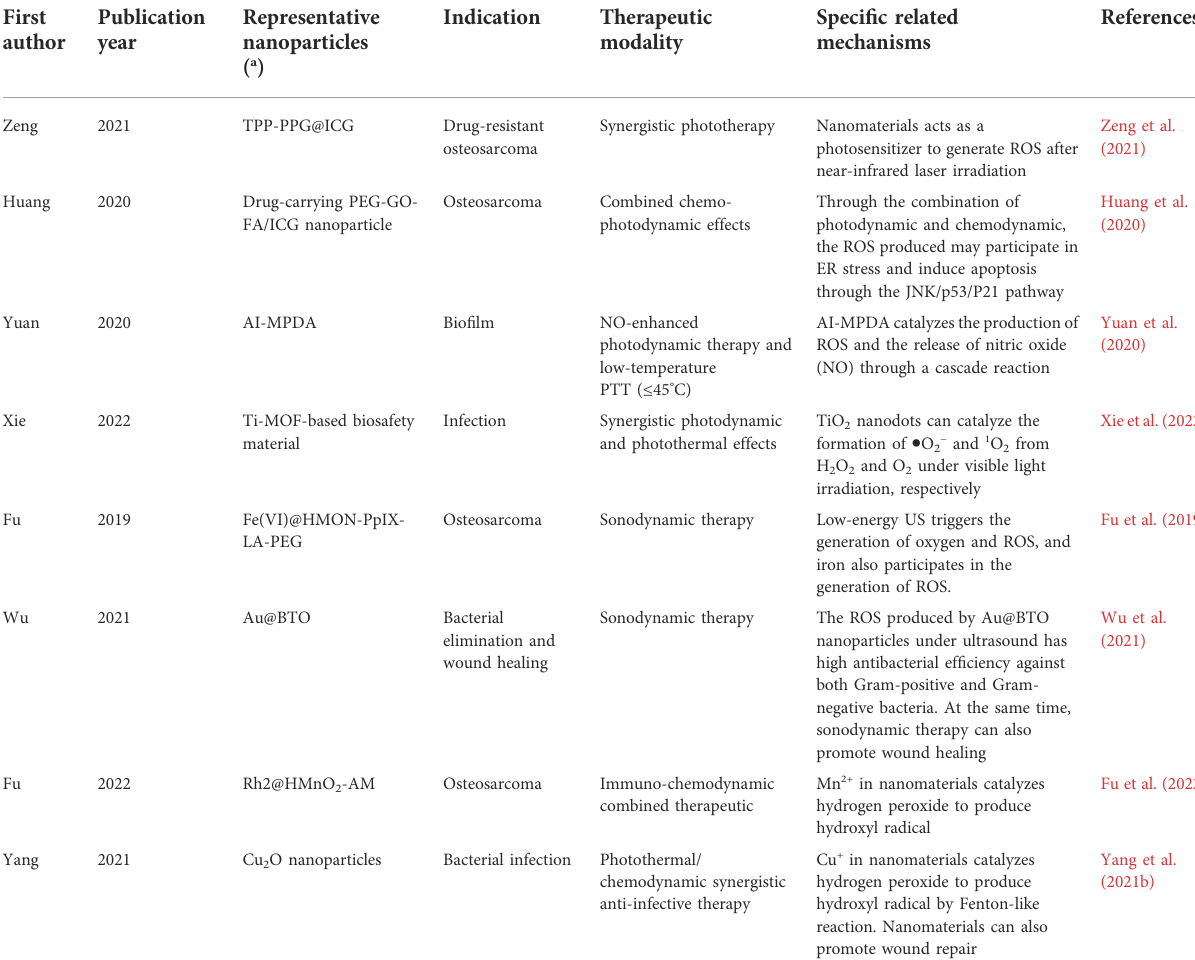
TABLE 3 Representative nanoparticles stimulated ROS generation and their